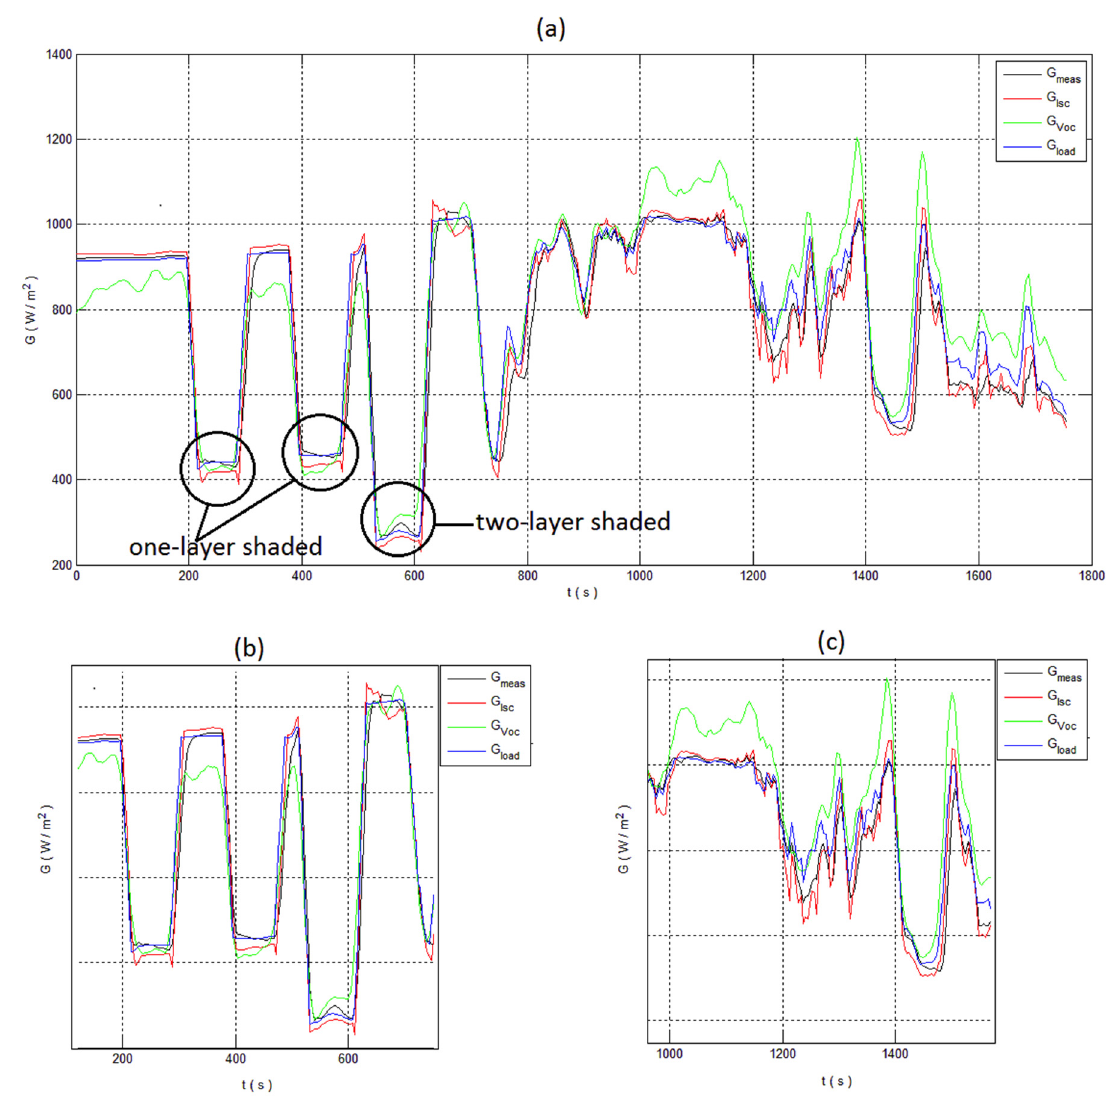
Figure 5. ( a ) Chart of the half-hour measure, showing the trend of G meas , G Isc , G Voc and G load ; ( b ) the artificial shading incidence caused by one or two layers shaded; ( c ) a zoomed view of the most variable time interval of the measurement session highlights the high difference among G meas , G Isc , G Voc and G load